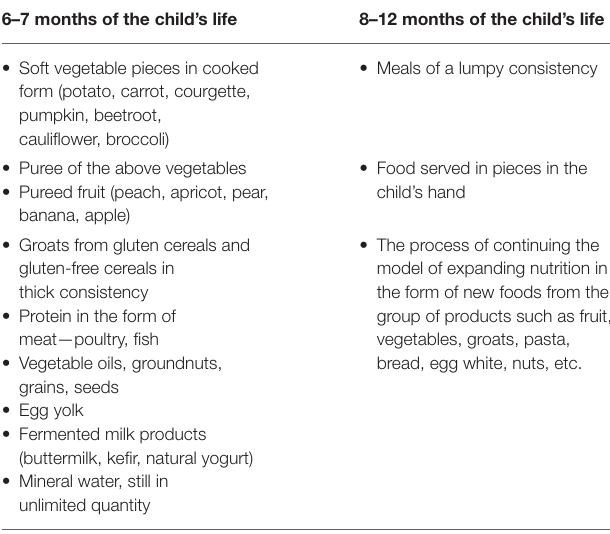
TABLE 1 | Proposal of implementation of complementary